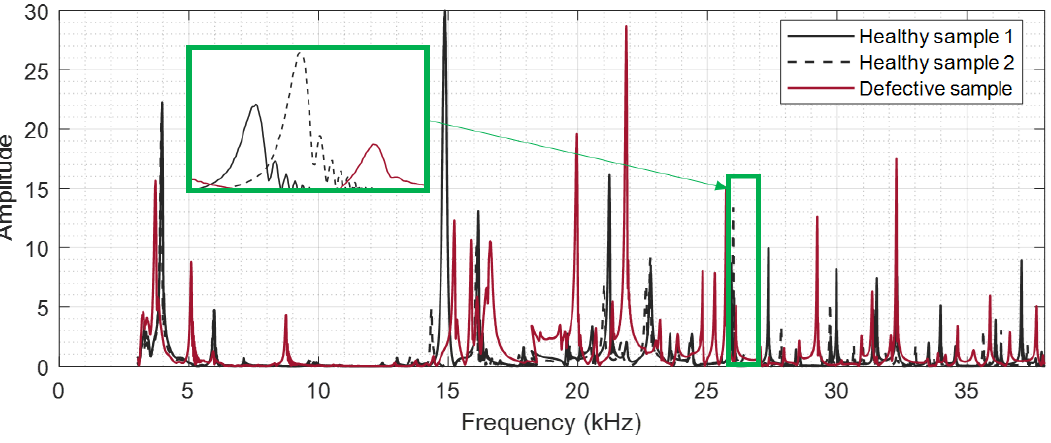
Figure 5. Frequency response functions (FRFs) of two healthy samples and one defective sample.